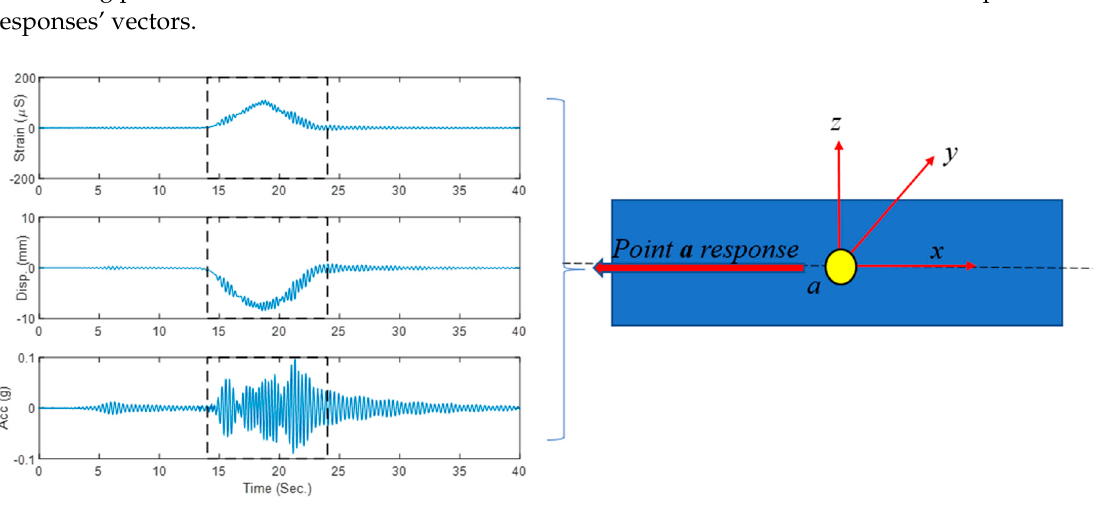
Figure 1. A schematic diagram of beam responses in the z direction.